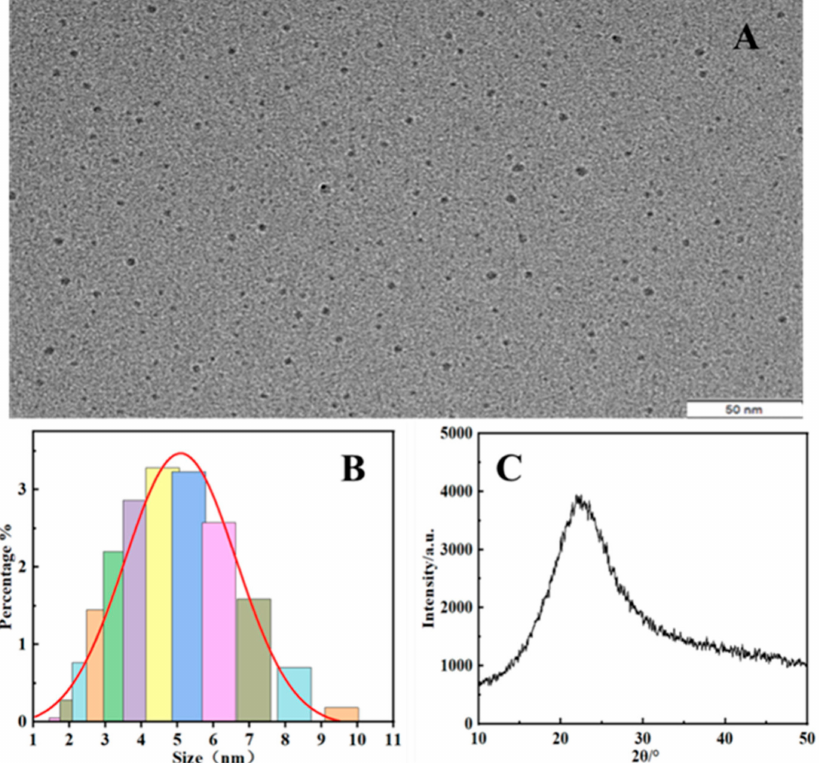
Figure 2. ( A ) TEM image of the synthesized PEI-CQDs; ( B ) PEI-CQDs’ particle-size distribution; ( C ) XRD pattern of